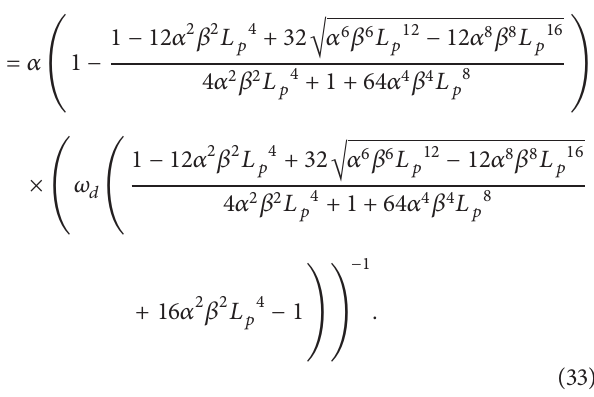
Figure 3: Black hole entropy as a function of mass for different numbers of space-time dimensions in the presence of GUP ∗ .